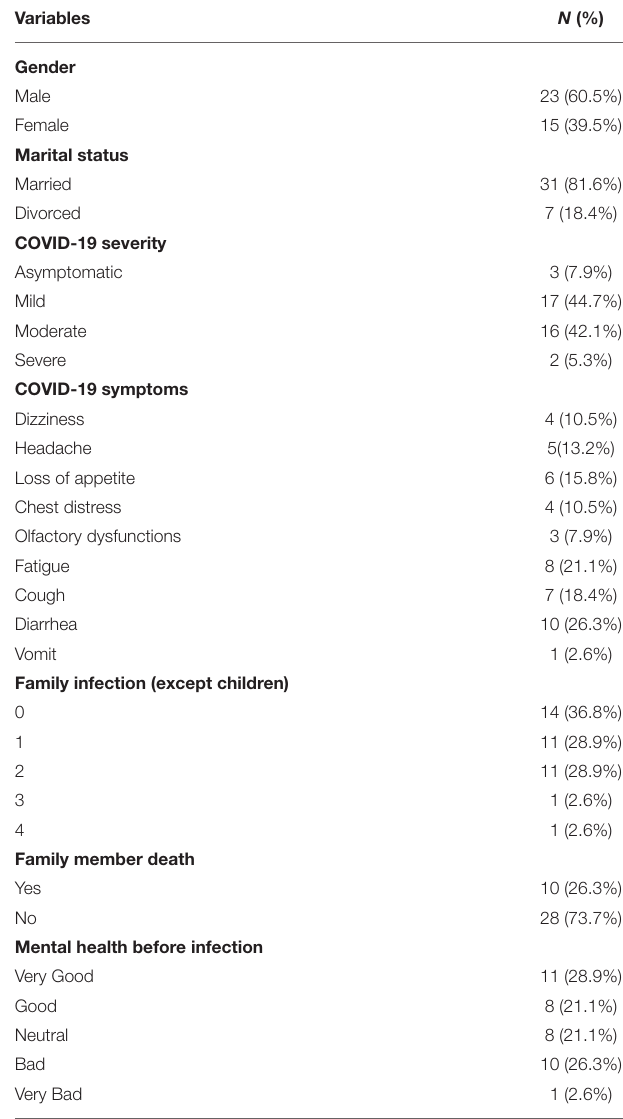
TABLE 1 | Characteristics of pediatric patients with